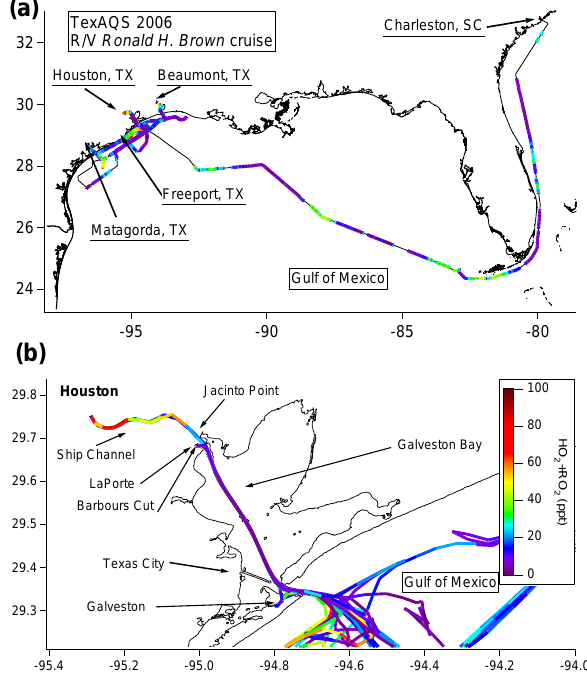
Fig. 3. Map of the Southern United States and the Gulf of Mexico showing the track of the R/V Brown during TexAQS 2006. The ship track is color-coded with HO 2 + ΣRO 2 measurements (in ppt ). Note that several transects overlap, especially in the Galveston Bay and in the Houston Ship Channel, and that mixing ratios larger than 100 ppt are not shown.